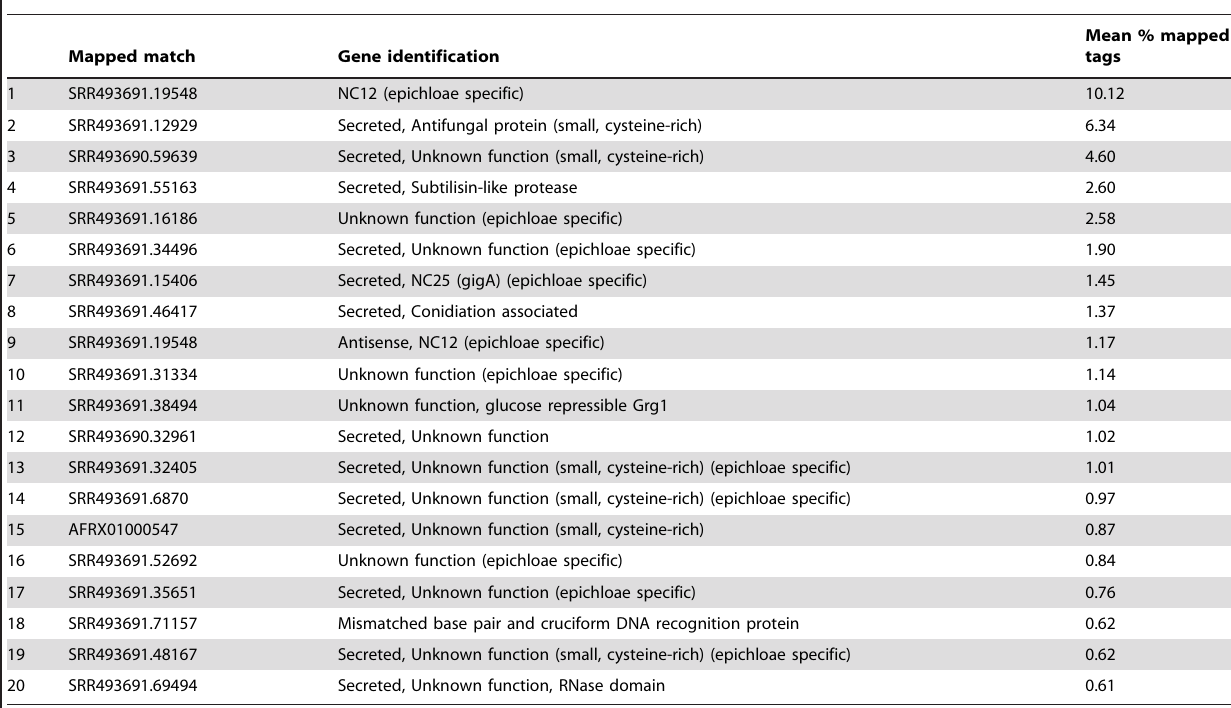
Table 4. The 20 most abundant E. festucae transcripts found in the endophyte-infected plant S1139RC.